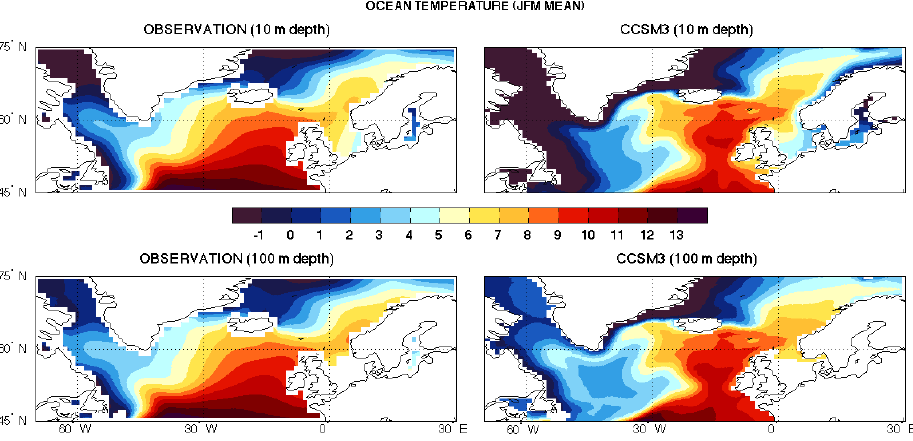
Fig. 3. Comparison of the mean annual temperature at 10m and 100m between CCSM3 and WOA98. NODC WOA98 data were provided by the NOAA/OAR/ESRL PSD, Boulder, Colorado, USA, from their Web site at http://www.esrl.noaa.gov/psd/.